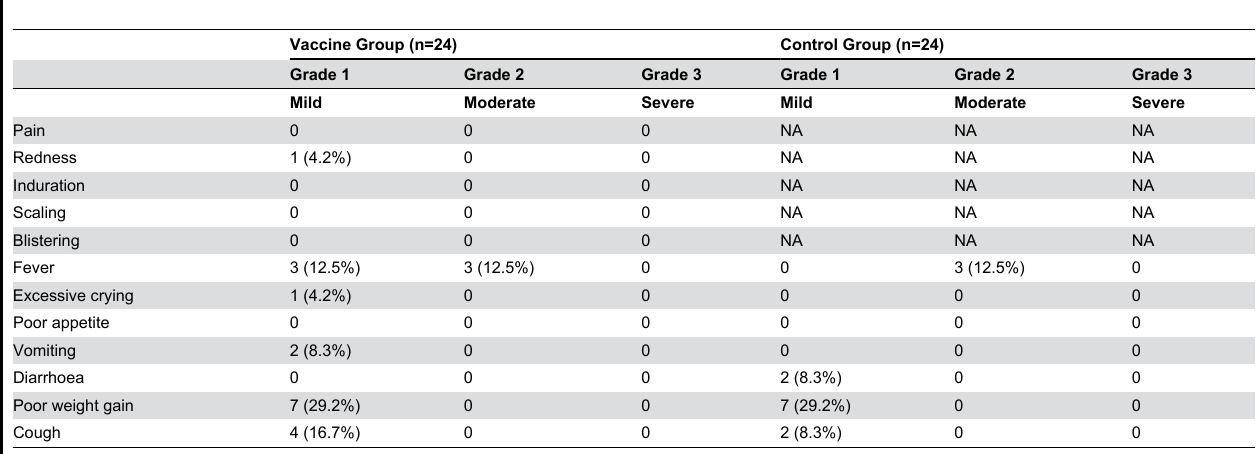
Table 3. Local and systemic AEs in the first 7 days of follow up.